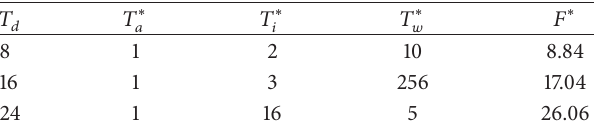
Table 2: Optimal parameters and objective function values for uniformly distributed 𝑇 𝑠 .